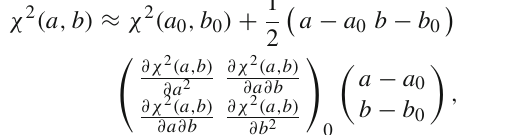
The parameters a 0 , b 0 that result in the global minimum χ 2 ( a , b ) min define the best fit to the data. They are shown as the cross in the right panel of Fig. 2, and produce the solid black curve shown in Fig. 1. At the same time one adopts a quadratic approximation to the χ 2 function in the vicinity of its